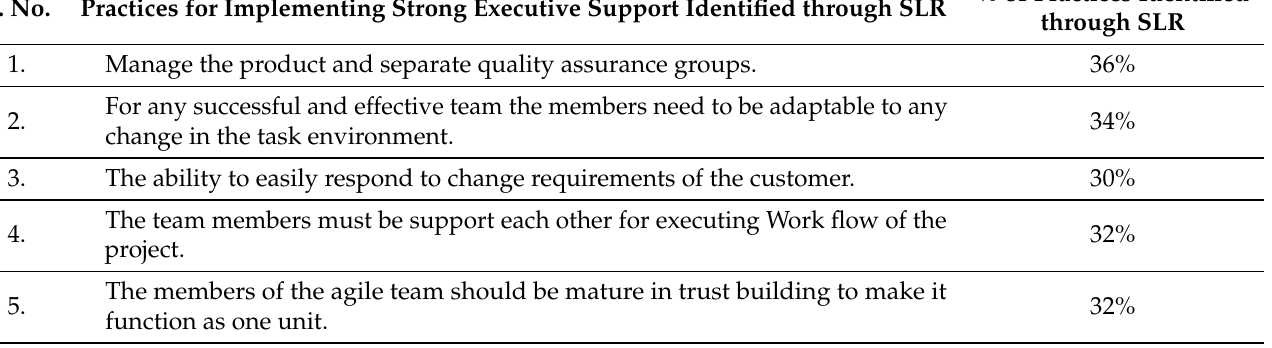
Table 3. Practices for implementing strong executive support.